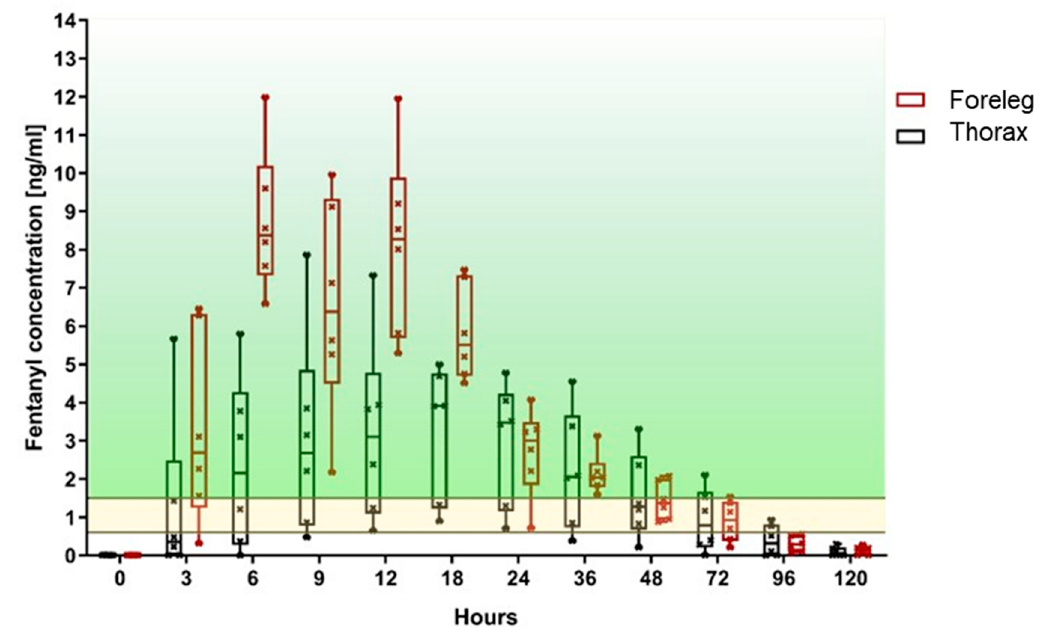
Figure 6. Fentanyl plasma levels measured over time for TFP applied at the foreleg ( red ) and thorax ( black ) displayed in a box plot graph (the fentanyl level within the area marked in yellow, corresponds to the minimal analgesic plasma level of 0.6–1.5 ng/mL described for humans; the area above marked in green represents values higher than 1.5 ng/mL).